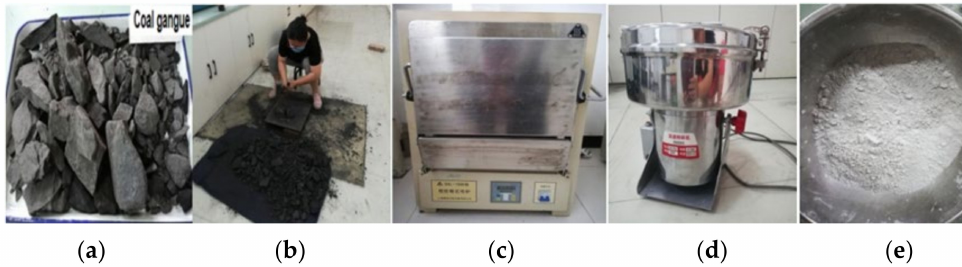
Figure 1. Flow diagram of preparation of UCGP. ( a ) raw coal gangue, ( b ) manual smash, ( c ) calcined